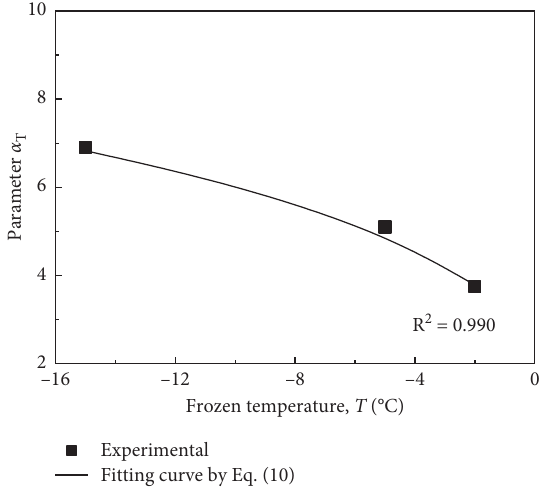
Figure 12: Relationship between parameter a